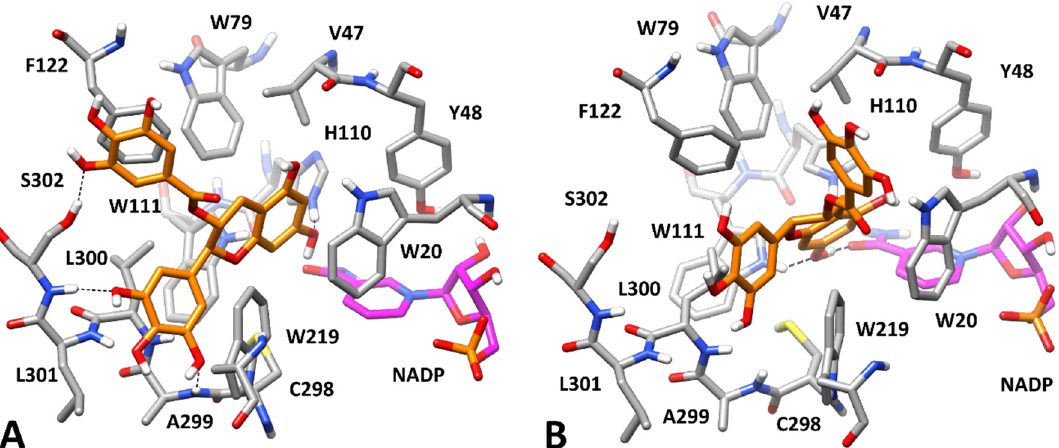
Figure 9. Minimized average structure of AKR1B1 complexed with GCG. Panel ( A , B ) refers to the AKR1B1 specificity pocket in the closed and open conformation, respectively (see text for details). GCG is shown in orange and the portion of the cofactor adjacent to the ligand binding site is shown in magenta. Relevant protein residues (shown in grey) are indicated. Ligand–protein H-bonds are shown as black dashed lines.